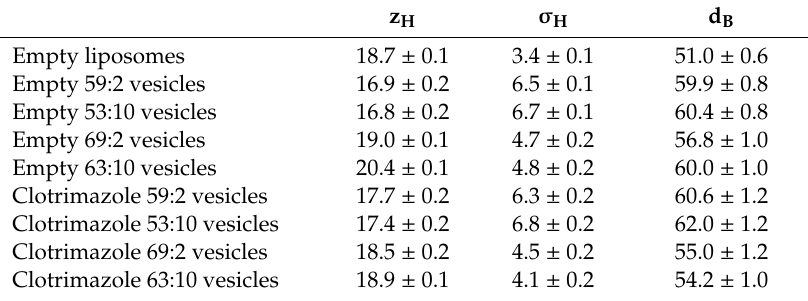
Table 3. Fitting parameters, σ H (polar head amplitude), z H (position of the headgroup Gaussian of the electron density profile), and d B (bilayer thickness) of empty and clotrimazole-loaded three-dimensionally-structured hybrid vesicles. Mean values ± standard deviation are reported. z H σ H d B Empty liposomes 18.7 ±